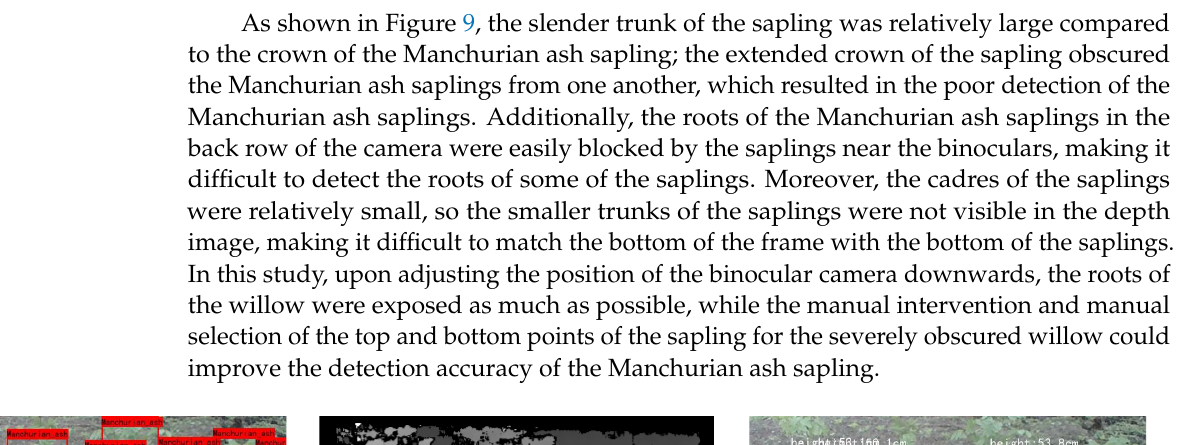
Figure 8. ( a ) Depth images; ( b ) height detection image; ( c ) number detection image; ( d ) interface detection image.